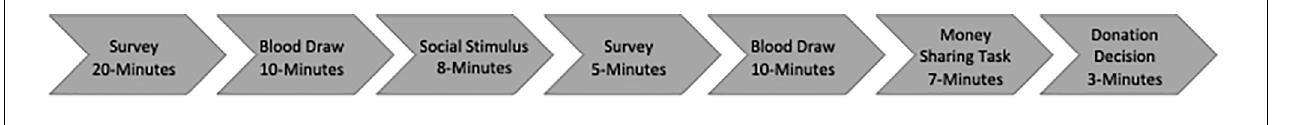
FIGURE 1 | Timeline of the experiment.